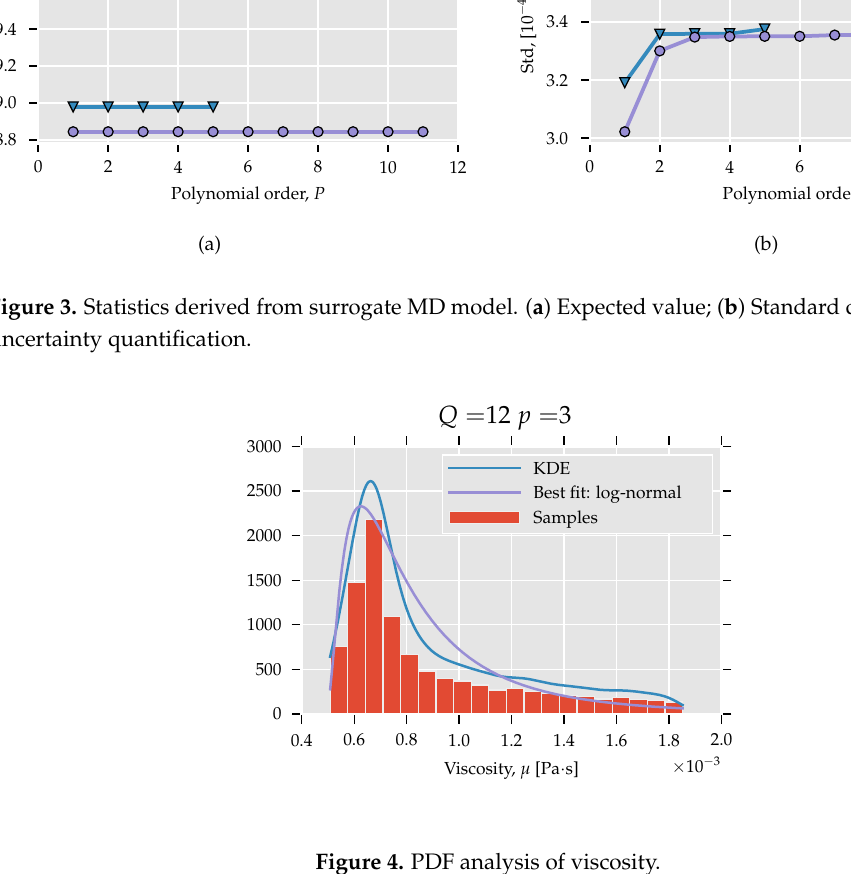
Figure 4. PDF analysis of